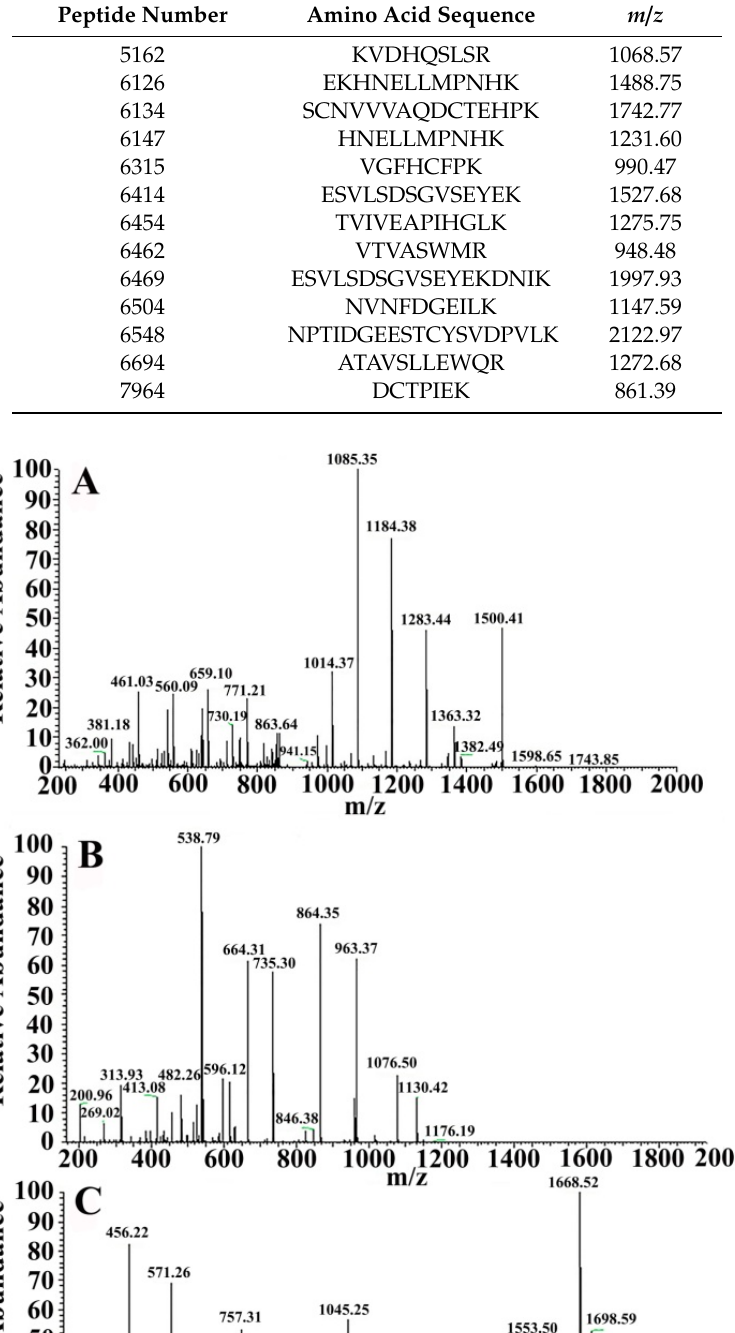
Table 5. The peptides of the VIT1 by Nano LC-ESI-MS/MS.